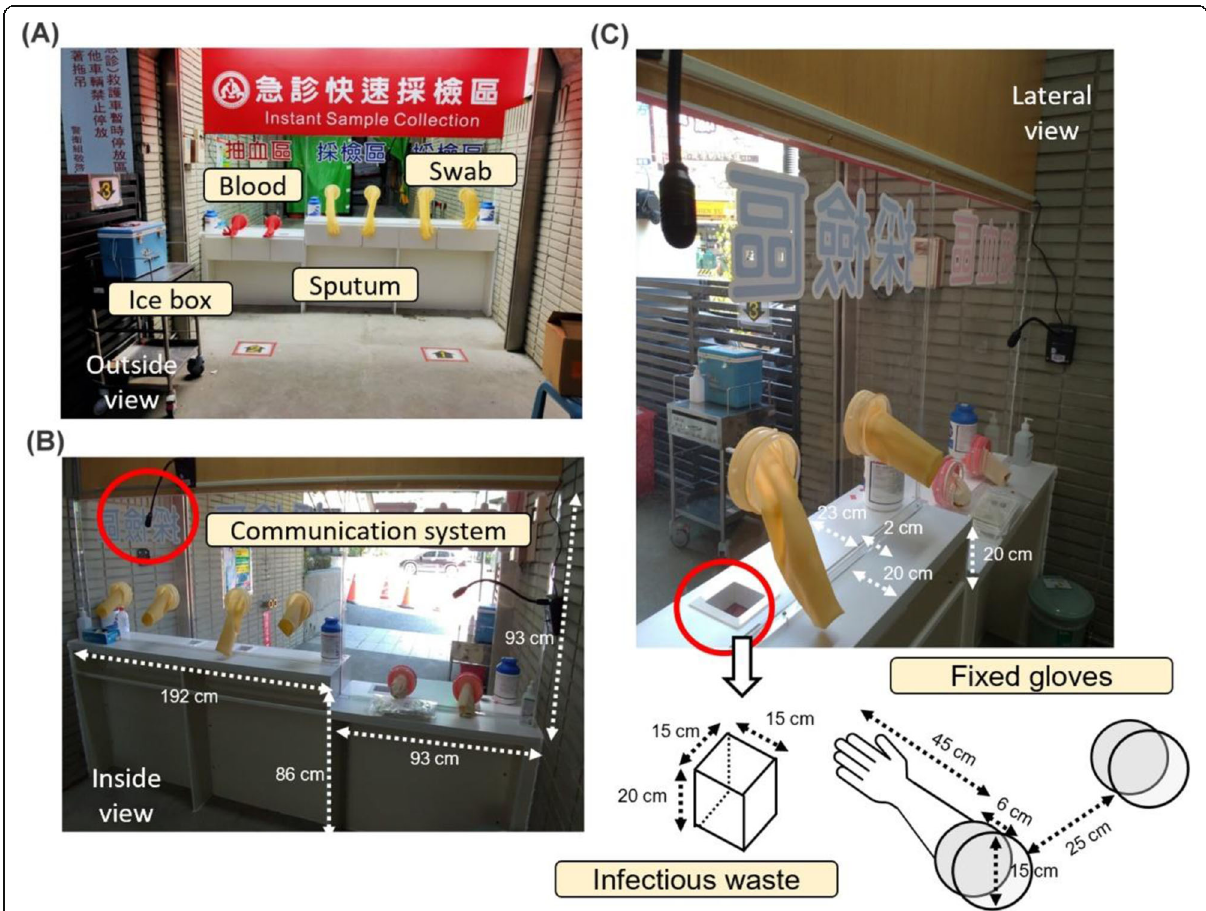
Fig. 2 a Outside, b inside, and c lateral views of the multifunctional sample collection station (MSCS). Before sampling, each patient would have